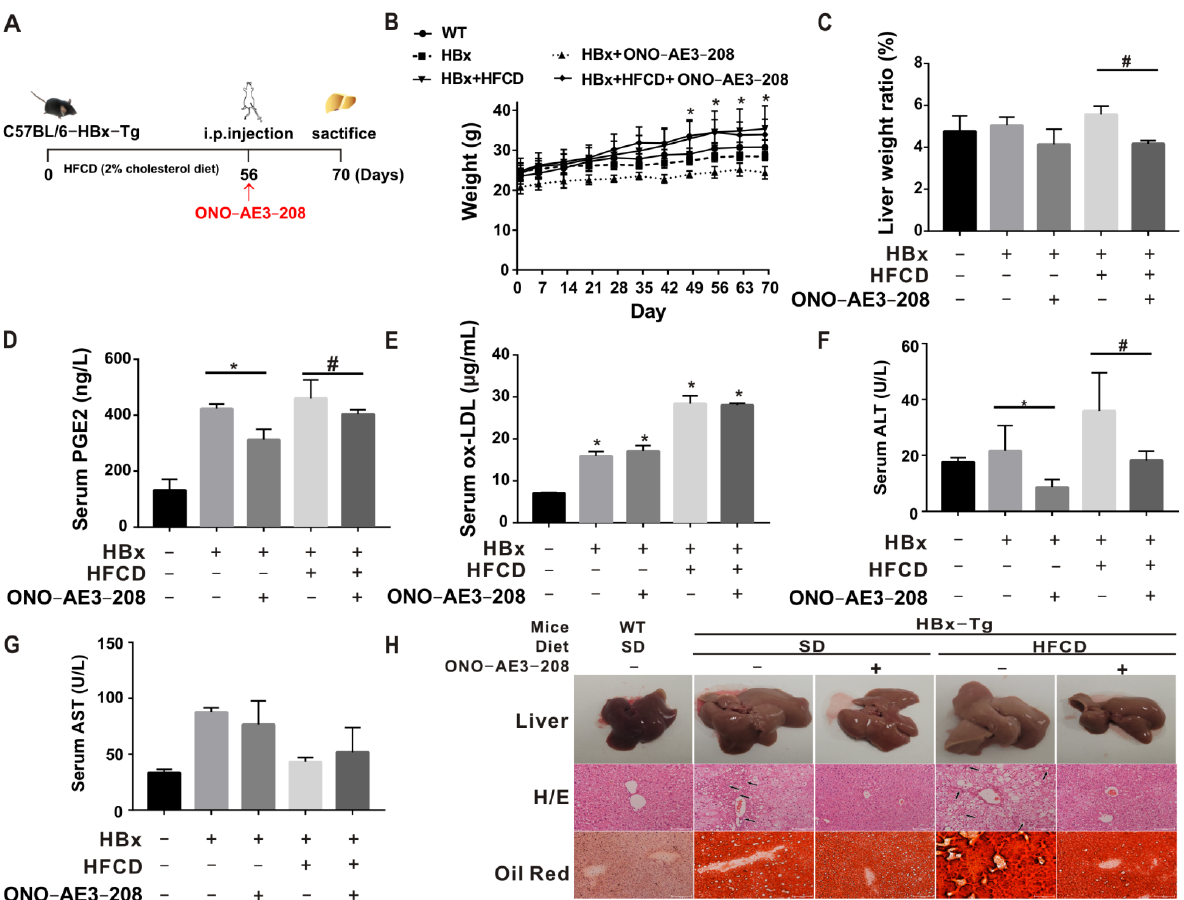
Figure 4. EP4 intervention reduced HBx-related lipotoxicity and NASH in vivo. C57BL/6-HBx-Tg (transgenic) mice and wildtype (WT) mice were used to establish related models fed a high-fat/cholesterol diet (HFCD) or the standard diet and administered ONO-AE3-208 (5 mg/kg, intraperitoneal injection, once every other day for 2 weeks) for EP4 intervention. ( A ) Experimental animal model and treatment model diagram in mice ( n = 3 in each group). ( B ) Body-weight growth curve. ( C ) Liver/body-weight ratio. ( D , E ) ELISA detection of PGE2 level ( D ) and ox-LDL level ( E ) in serum. ( F , G ) Detection of ALT and AST in serum. ( H ) Representative images of the NAFLD/NASH phenotypes (liver morphology, H/E staining, and Oil Red O staining). Scale bar 100 µ m. Black arrows indicate inflammatory foci. The data are presented as the mean ± SD. * p < 0.05, compared with the WT or HBx group. # p < 0.05, compared with the HBx + HFCD group. Table 1. NASH scoring for the HBx-related NASH and EP4 intervention in vivo.